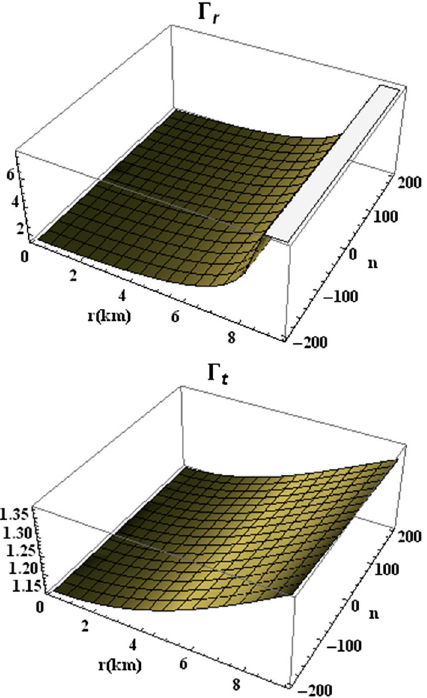
dimensionless quantity. (Right) Along x -axis, y -axis and z -axis we have respectively plotted the radius of the star in km unit, the dimensionless quantity n which lies in the range − 200 ≤ n ≤ 200 and the difference between transverse and radial velocity of sound is a dimensionless quantity. All the profiles are drawn for a compact star of mass M = 1 . 85 M (cid:3) and radius of the star = 9 . 5km by fixing (cid:27) b = 0 . 0095 km − 1 dp t which is a d ρ